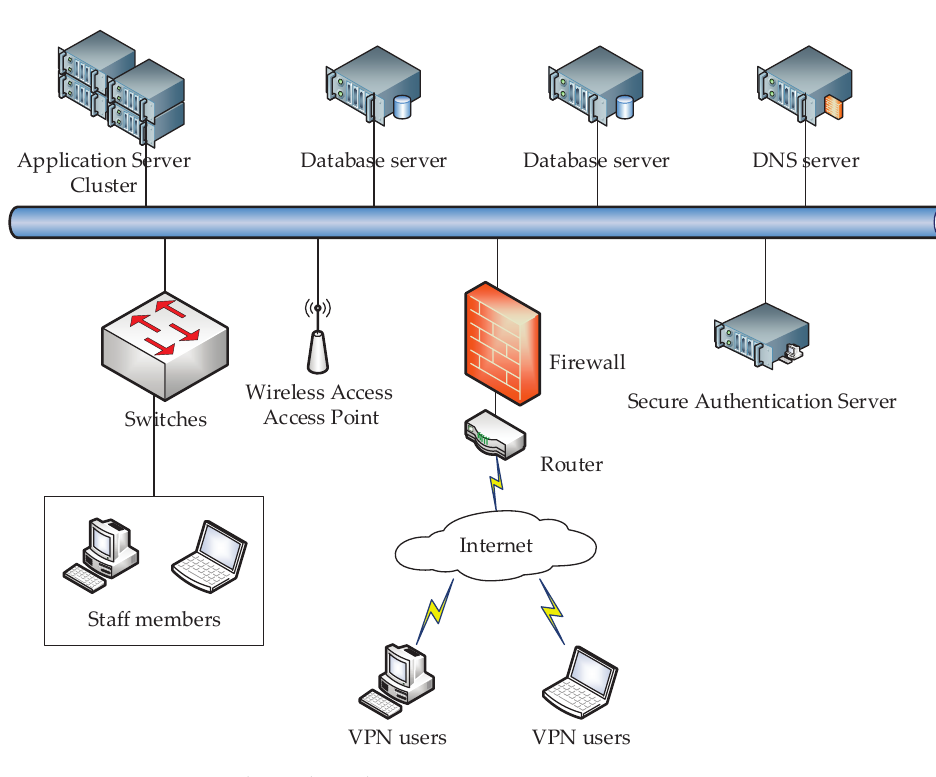
Figure 3. System network topology